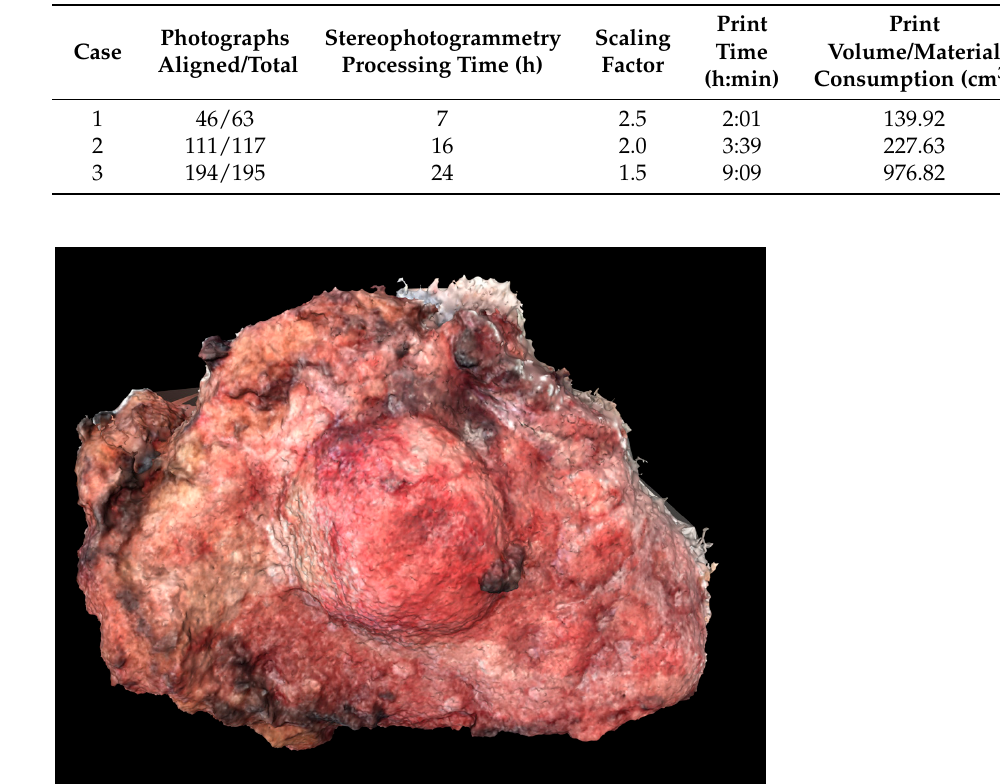
Figure 5. Digital 3D model of Case 2 using Meshlab.